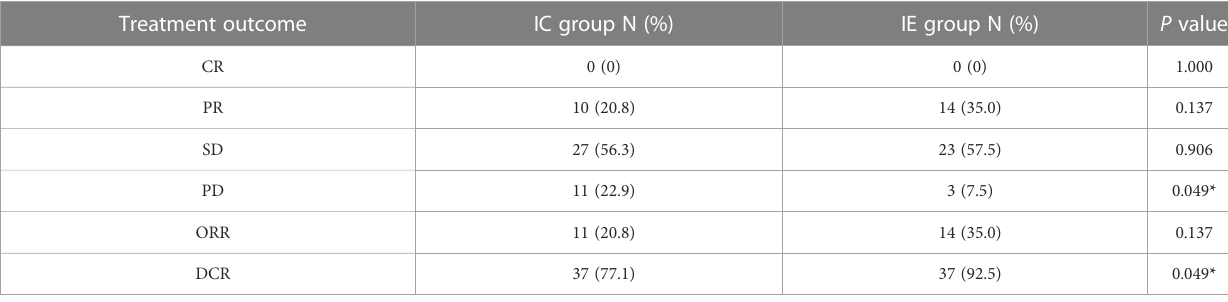
TABLE 2 Treatment outcome of patients in the two